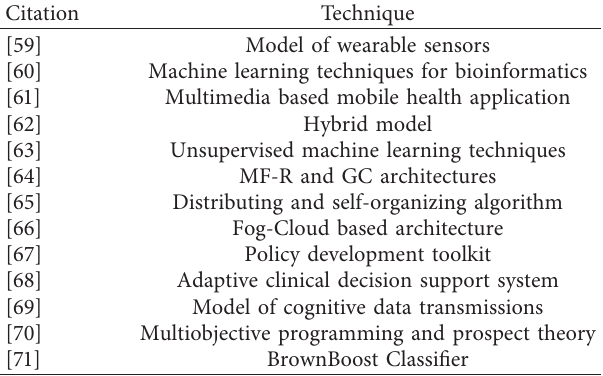
Table 1: Research in the area of healthcare based on big data.